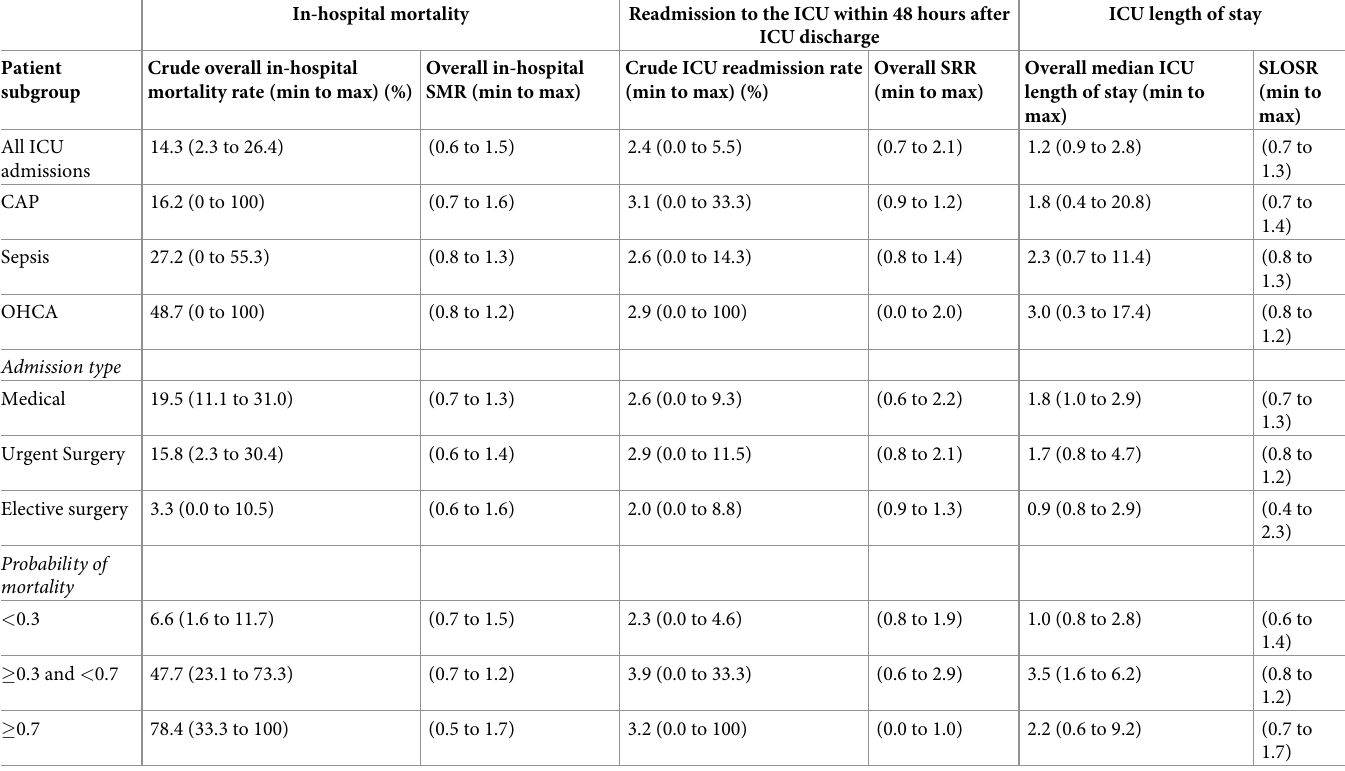
Table 1. Values for the crude outcomes and for the quality indicators standardized mortality ratio (SMR); standardized readmission ratio (SRR) and standardized ICU length of stay ratio (SLOSR). Overall values are shown with minimum and maximum ranges over the